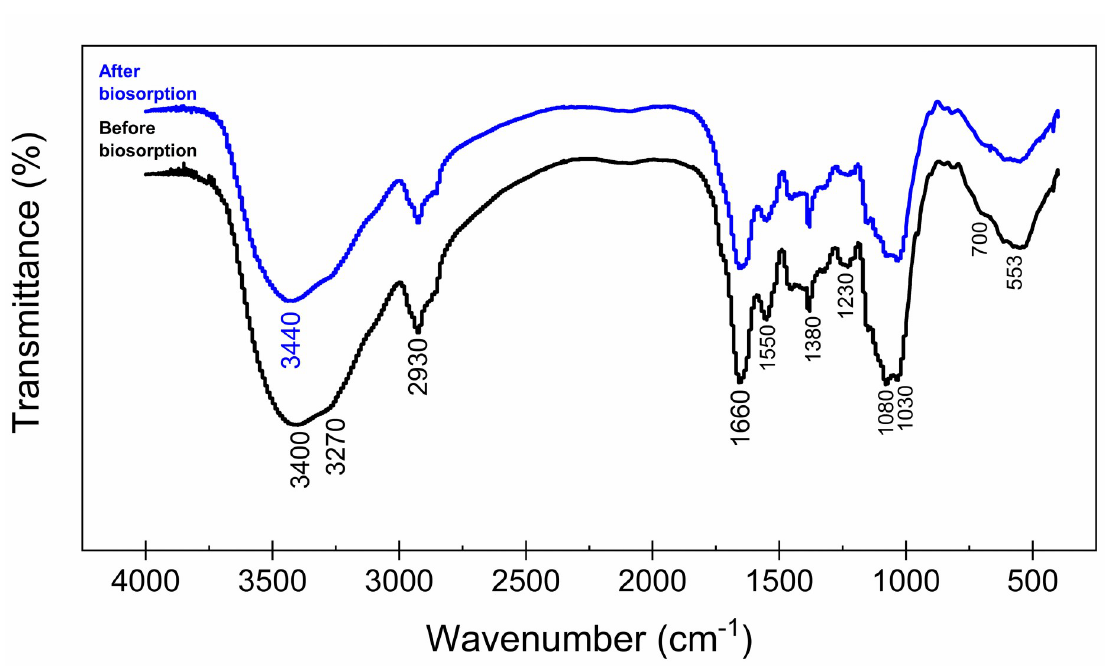
Fig 5. FT-IR spectra of fungal biomass before and after copper